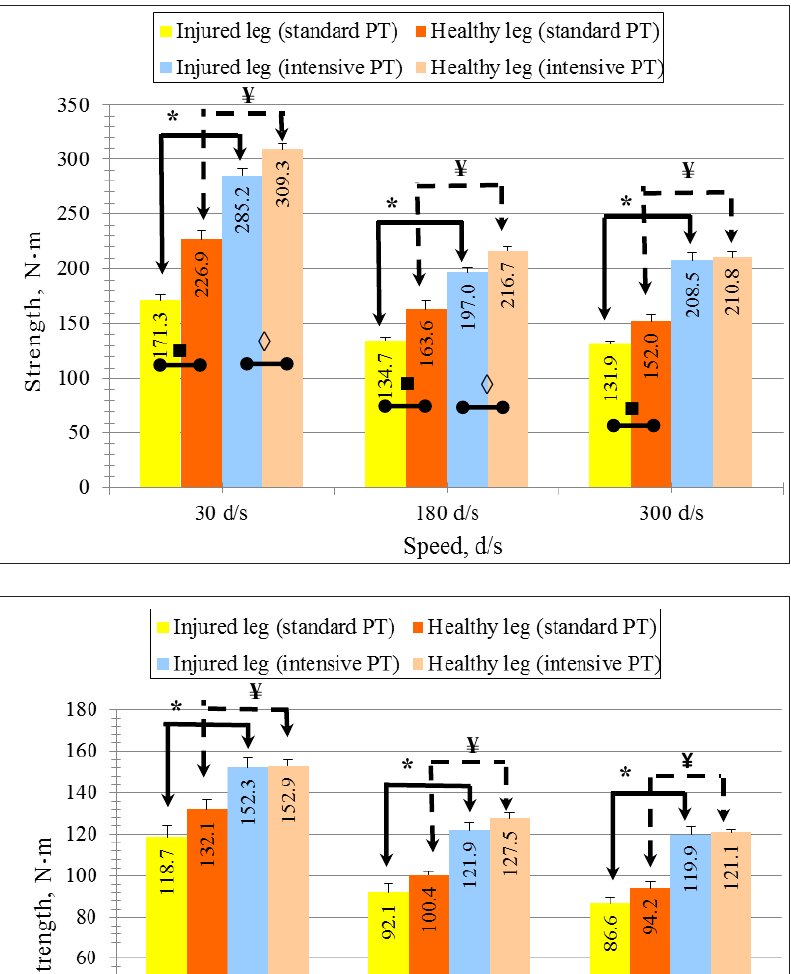
Figure 3. Healthy and injured leg, different physical therapy techniques, maximum muscular extension strength at different speed of muscle contraction, after surgery